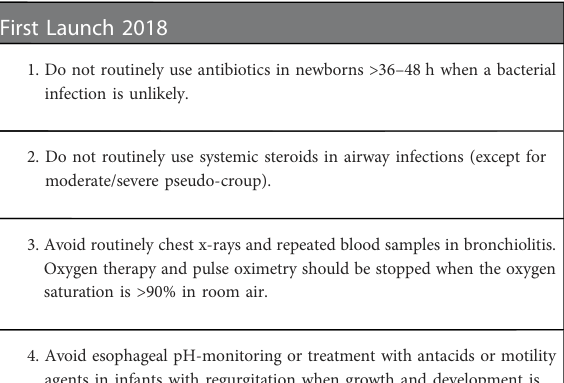
TABLE 3 Norwegian pediatric associations ’ recommendations